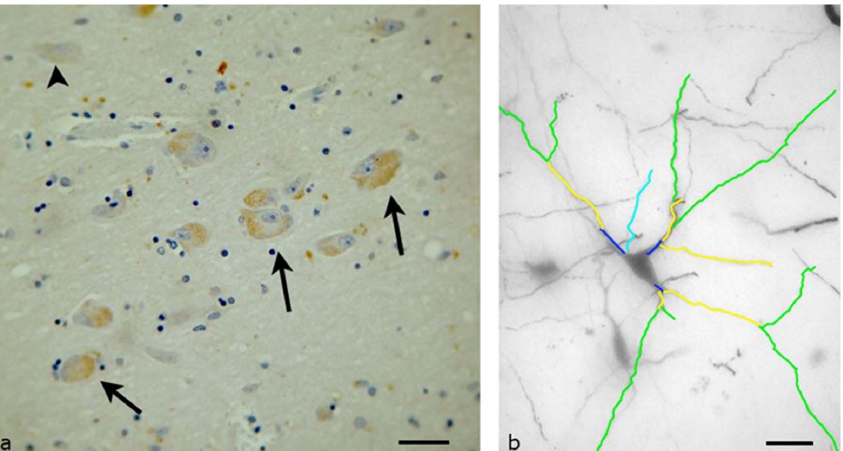
Figure 1. Lateral Hypothalamic Area of the human Hypothalamus: ( a ) Immunohistochemical staining, specific for OX1R. Small neural circuits of three to four neurons are more immunopositive (black arrow) than large, isolated neurons, which have little OX1R expression (arrow heads) (Scale bar, 25 μ m); ( b ) A Golgi-stained neuron mapped by the ImageJ program. Primary (dark blue), secondary (yellow) and tertiary (green) dendrites can be found. Light blue depicts the axon of the neuron (Scale bar, 20 μ m).